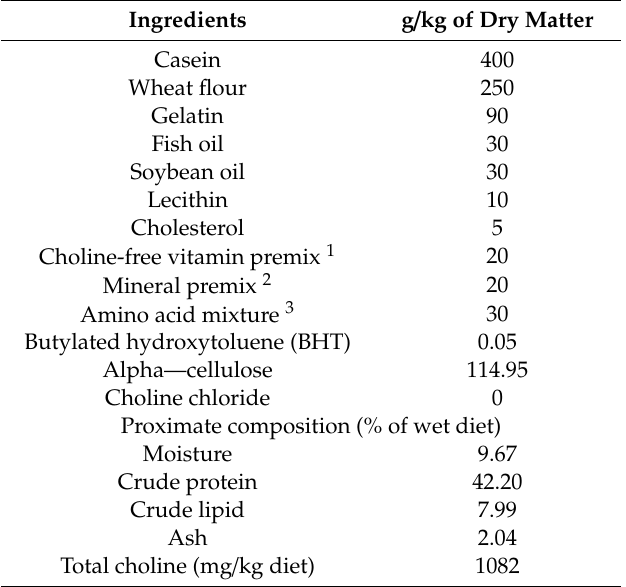
Table 1. The animal ethics protocol was approved by the Hainan University Experimental Animal Ethics Committee (No. HNUAUCC-2020-00005). Table 1. Ingredients and proximate composition of the basal diet. Ingredients g / kg of Dry